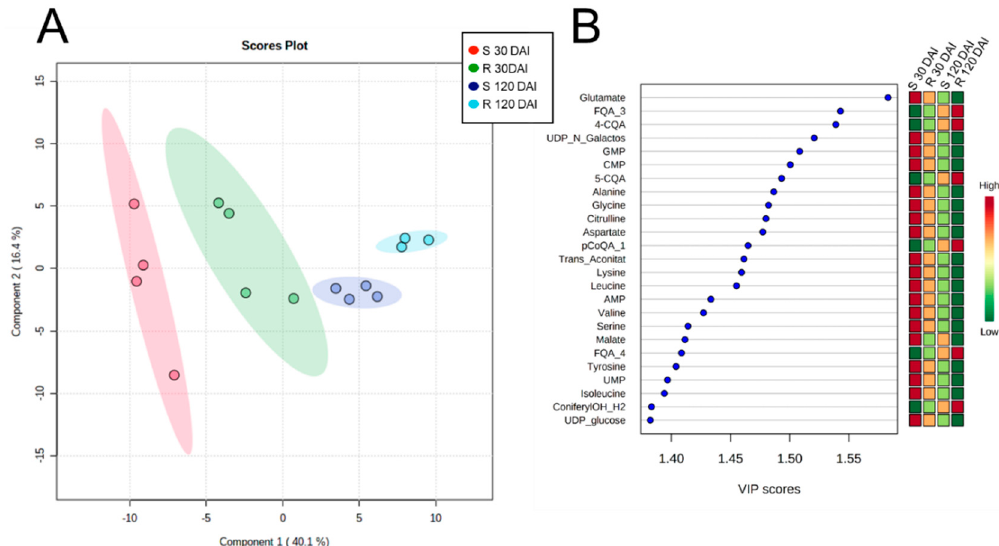
Figure 3. PLS-DA cluster ( A ) and the 20 most important features ( B ) of leaves extracts from mock-inoculated S and R varieties collected at 30 and 120 DAI quantified by targeted metabolomics. Shaded red, green, blue, and cyan regions in ( A ) represent 95% confidence intervals. Colors in the Variable Importance in Projection (VIP) plot represent relative abundance. Abbreviations: FQA_3, feruloylquinic acid isomer 3; 4-CQA, 4-caffeoylquinic acid; UDP_N_Galactos, uridine diphosphate-N-galactosamine; GMP, guanosine monophosphate; CMP, cytidine monophosphate; 5-CQA, 5-caffeoylquinic acid; pCoQA_1, isomer 1 of p-coumaroylquinic acid; Trans_Aconitat, trans-aconitate; AMP, adenosine monophosphate; FQA_4, isomer 4 of feruloylquinic acid; UMP, uredine monophosphate, ConiferylOH_H2, coniferyl alcohol (-H 2 O); UDP_glucose, uracil diphosphate glucose.